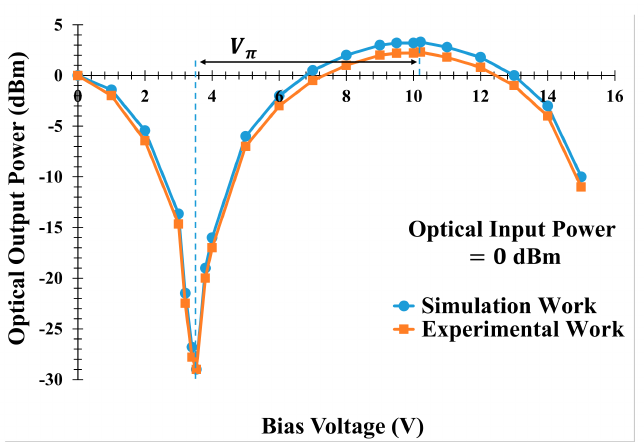
Figure 3. MZM static characteristic for simulation and experimental works.